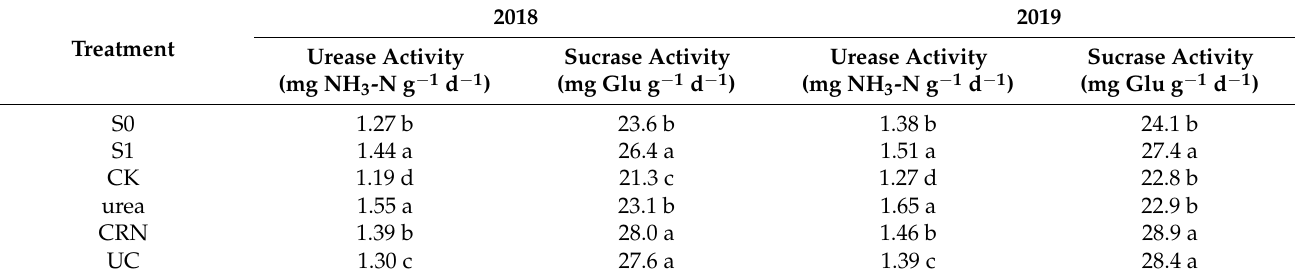
Table 6. Effects of straw management combined with N-fertilization strategy on soil enzyme activity at